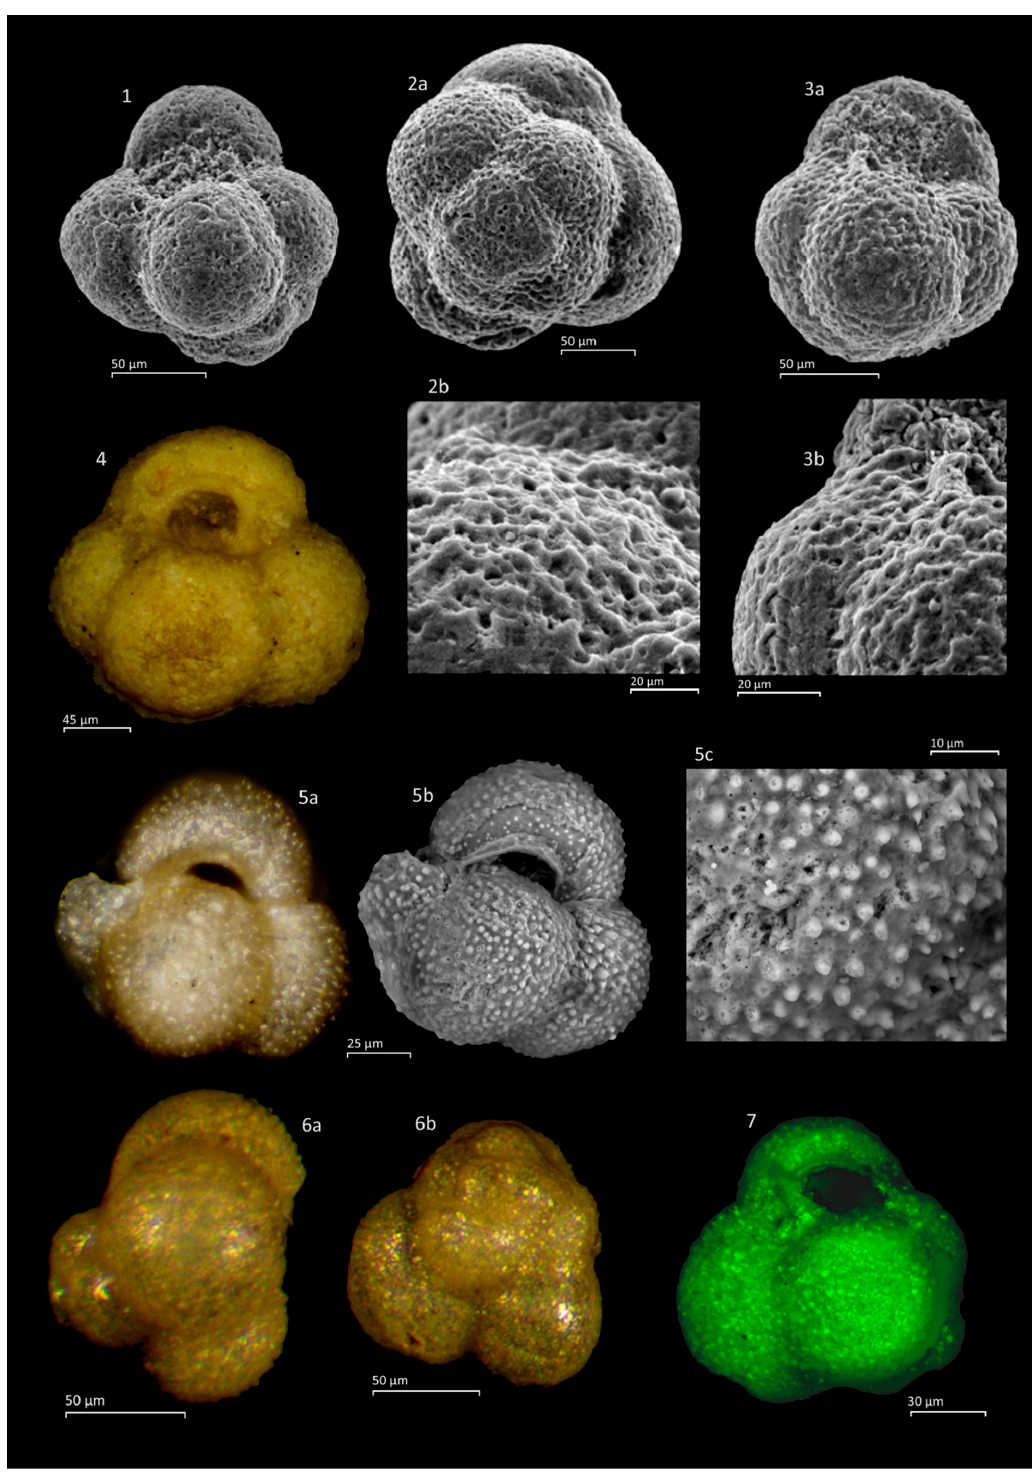
Figure A3. Conoglobuligerina helvetojurassica (Haeusler). Subfigures 1 – 3 , holotype and paratype specimens from sample 4.mid, Eisengraben Section, Birmerstorfer Schichten, Transversarius Zone, Middle Oxfordian, Canton Aargau, Swizerland; note reticulate wall texture. Subfigure 4 , sample 24/2P, Tojeira Formation, Lower Kimmeridgian, Montejunto, Portugal. Globuligerina waskowskae Gradstein. Subfigures 5 – 7 , holotype and paratype specimens, sample 6, Morrisi Zone, Middle Bathonian, Gnaszyn, Poland; note microperforate wall with small, regularly distributed pustules, many with pore